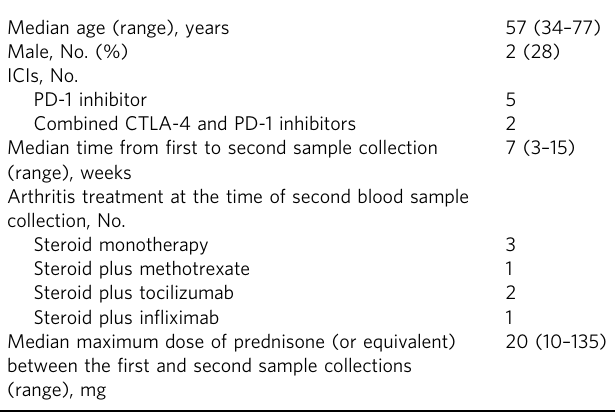
Table 2 Demographic and clinical characteristics of patients included in the longitudinal peripheral blood